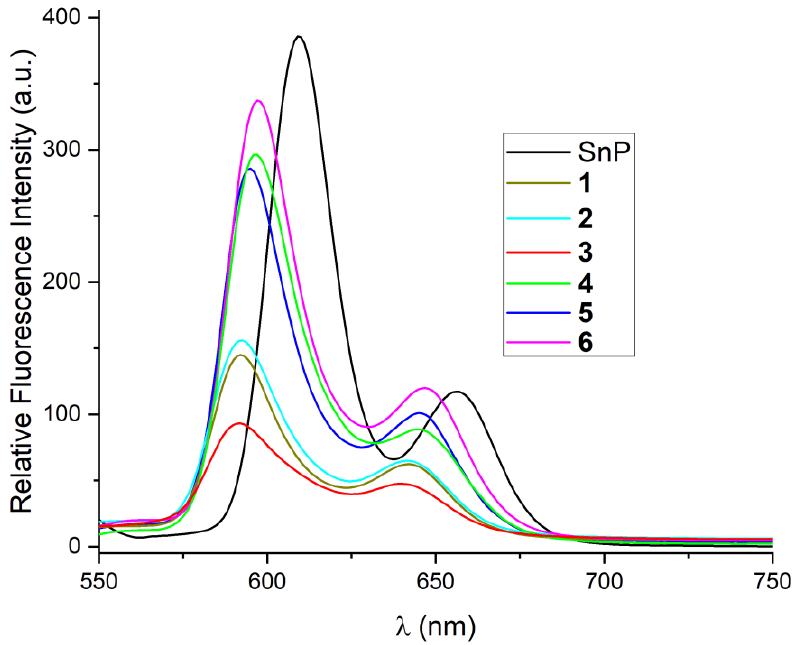
Figure 2. Fluorescence spectra of triads 1 – 6 and SnP in CHCl 3 . The optical density (OD) of each sample solution was fixed at 0.20.